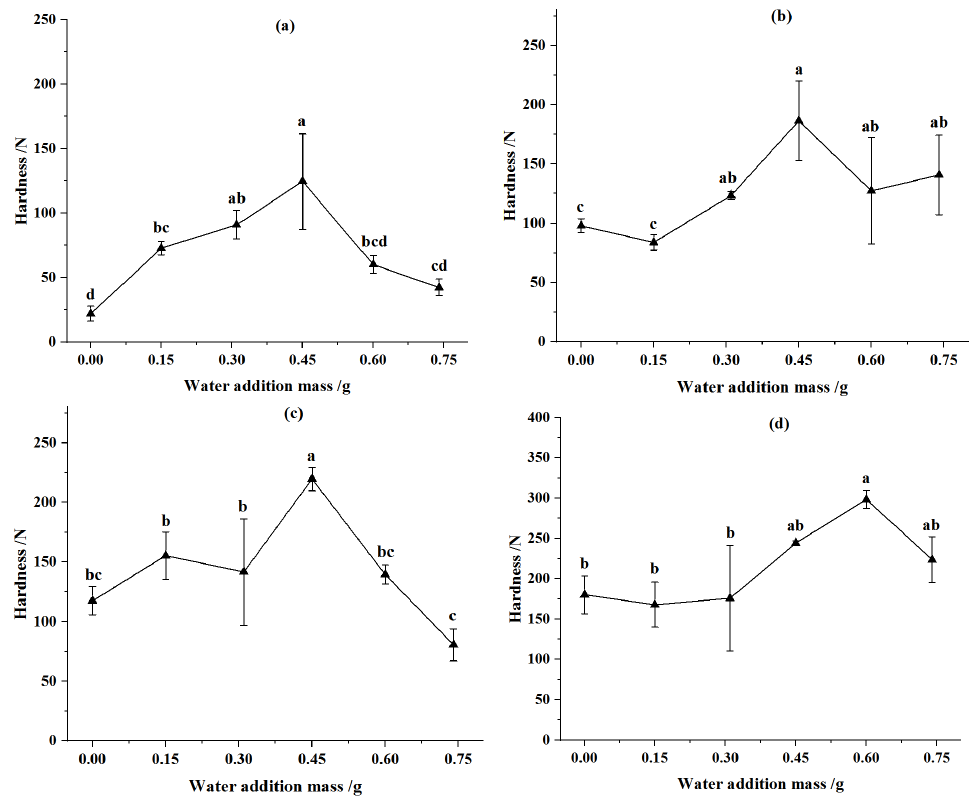
Figure 5. Effect of water addition on hardness of pellets. ( a ) Particle size was 2 mm and compression displacement was 90 mm. ( b ) Particle size was 4 mm and compression displacement was 90 mm. ( c ) Particle size was 2 mm and compression displacement was 92 mm. ( d ) Particle size was 4 mm and compression displacement was 92 mm. Note: Different letters in the same line chart indicate a significant difference between the data ( p < 0.05).